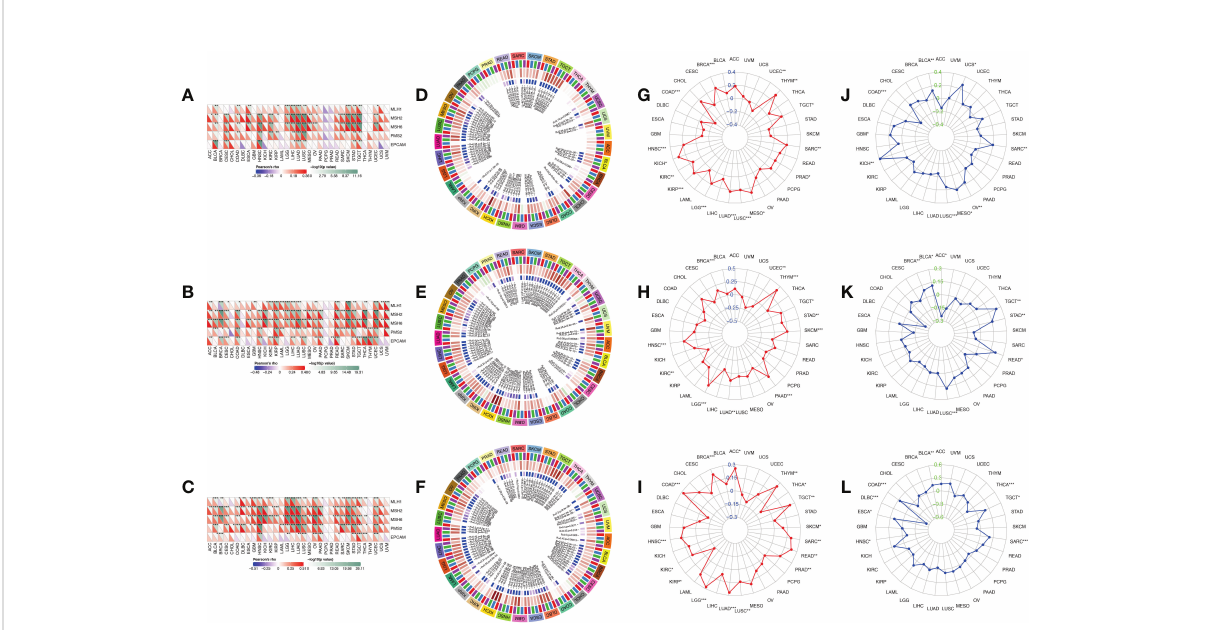
FIGURE 4 Correlation analysis between IGF2BPs expression and MMR, DNA methylation level, TMB, and MSI in pan-cancer. (A-C) The Spearman correlation analysis of IGF2BPs expression with expression levels of fi ve MMR genes across cancers. (D-F) The Spearman correlation analysis of IGF2BPs expression with the expression of 4 methyltransferases, Red represents DNMT1, blue represents DNMT2, green represents DNMT3A, and purple represents DNMT3B. (G-I) The correlation analysis between IGF2BPs expression and TMB in pan-cancer. (J-L) The correlation analysis between IGF2BPs expression and MSI in pan-cancer. *P < 0.05, **P < 0.01, ***P <